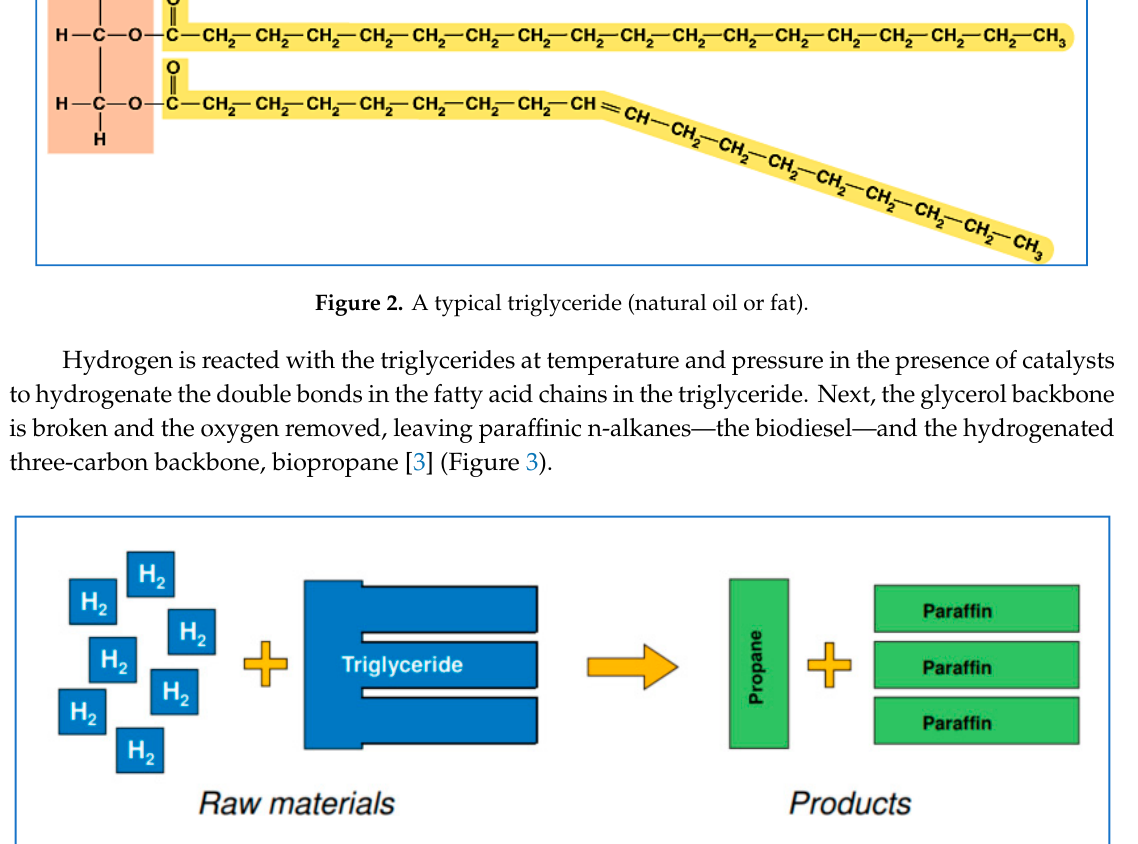
Figure 3. A schematic view of the process, bio ‐ oil to biodiesel and biopropane.